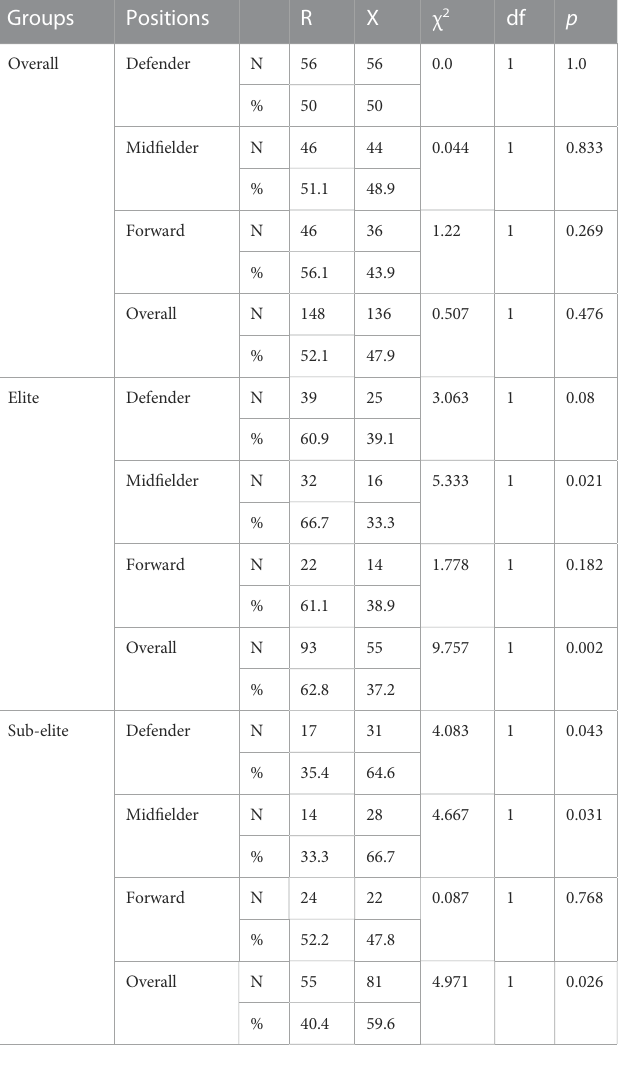
TABLE 3 The comparison of allele frequencies in each elite and sub-elite goalkeeper, defender, mid fi elders and forward player. Groups Positions